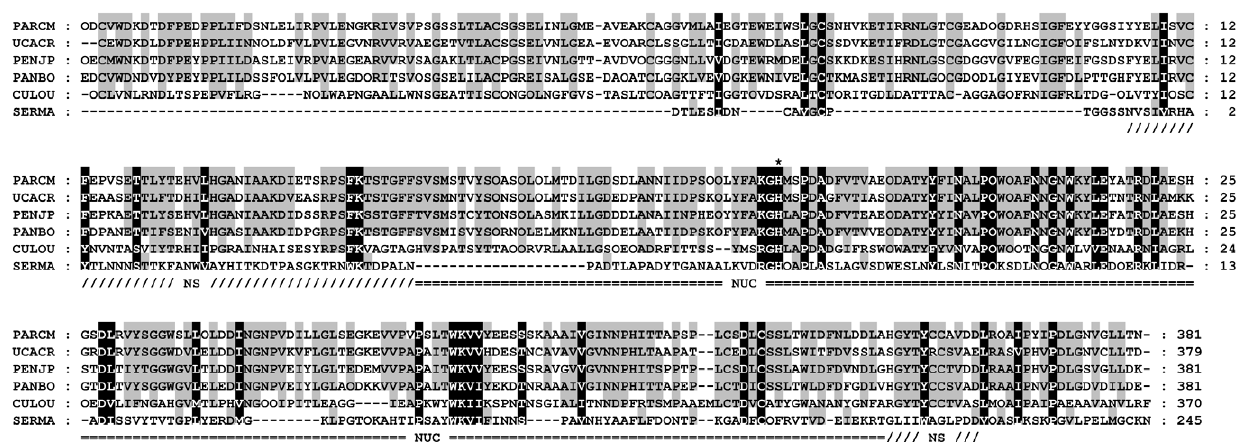
Figure 7. Multisequence alignment of selected NUC endonucleases. Retrived sequences were stripped for signal peptide sequences and aligned using Clustal W2. Amino acids are shaded by degree of conservation (grey for major, black for total). An asterix marks the site of a histidine residue previously reported essential for catalytic activity. Recognised endonuclease NS and NUC domains are indicated according to their occurrence in the P. borealis enzyme. The sequences used are from Northern shrimp (PANBO - C9YSL6), Kuruma prawn (PENJP - Q9U5L8), Red king crab (PARCM - B6ZLK3), Fiddler crab (UCACR - Q0GIJ2), Southern house mosquito (CULQU - B0WUW1), and the gram-negative bacterium Serratia marcescens